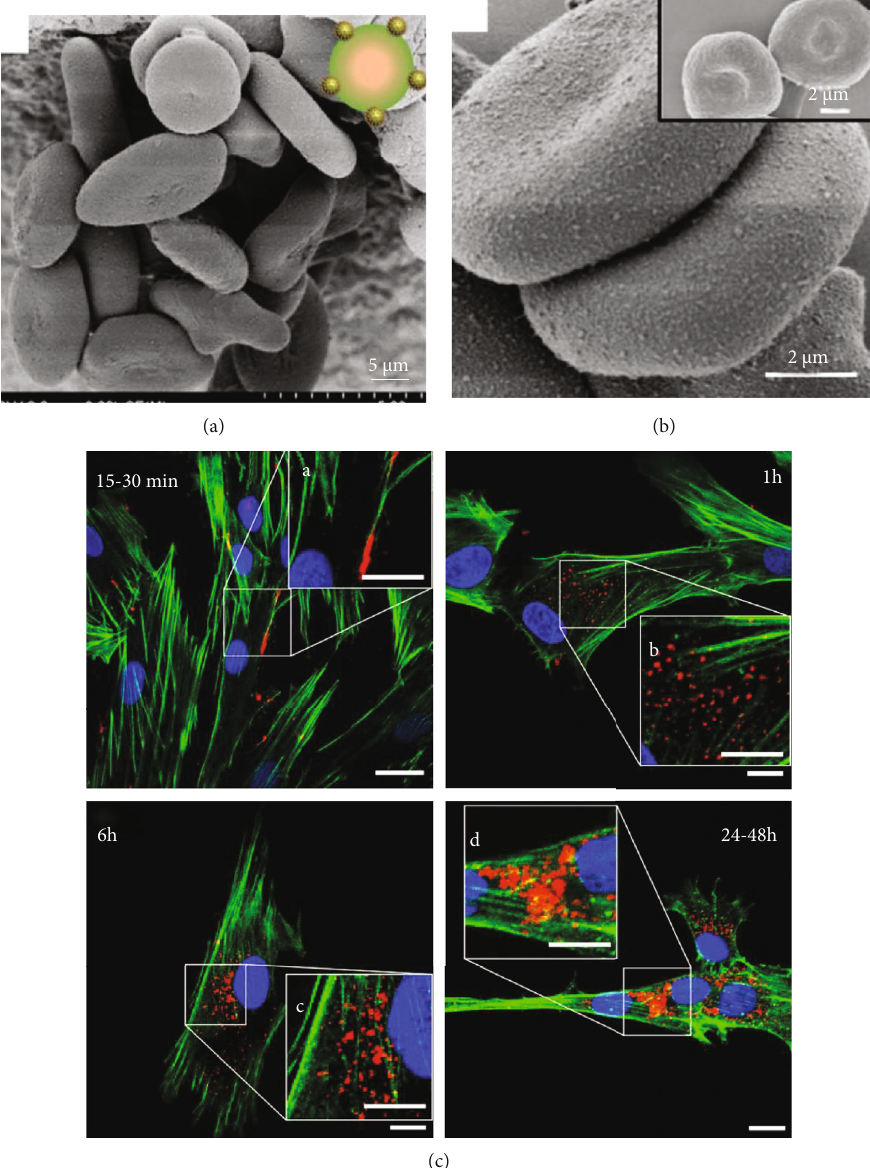
Figure 3: Backpack and encapsulation approaches. (a) Scanning electron microscope (SEM) images of RBCs which were backpacked with multitheranostic probes for cancer surgery guidance and therapy. (b) SEM images of higher magni fi cation of cargo-loading RBCs, and the insert shows naked RBC images. Reproduced with permission [48]. Copyright 2019. Ivyspring International Publisher. (c) Confocal micrographs of quantum dot distribution in MSCs after 15 – 30min, 1h, 6 h, and 24 – 48h incubation. Nuclei, Hoechst blue; actin, Phalloidin green; quantum dots, red. Scale bar for main images, 15 μ m; scale bar for insert images, 10 μ m. Reproduced with permission [40]. Copyright 2017. Dove Medical